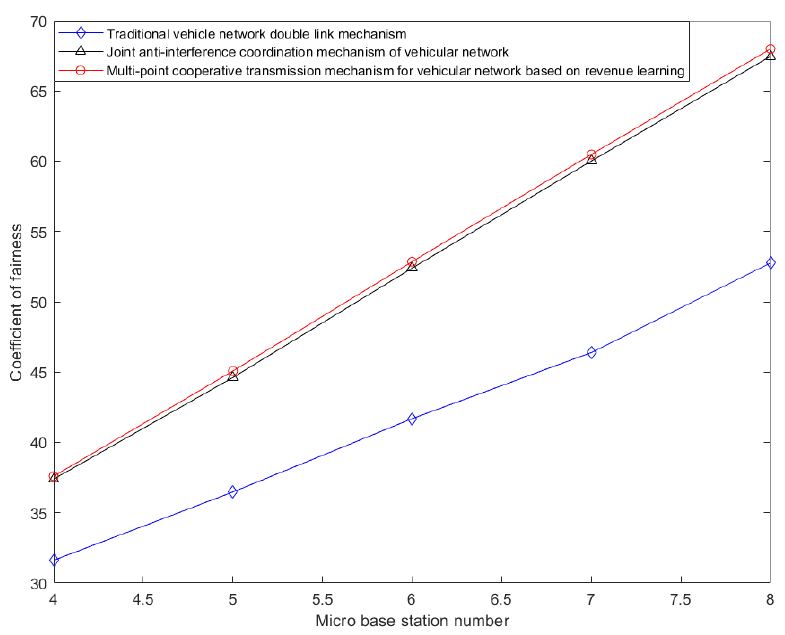
Figure 8. Comparison of fairness coefficients under no policy.